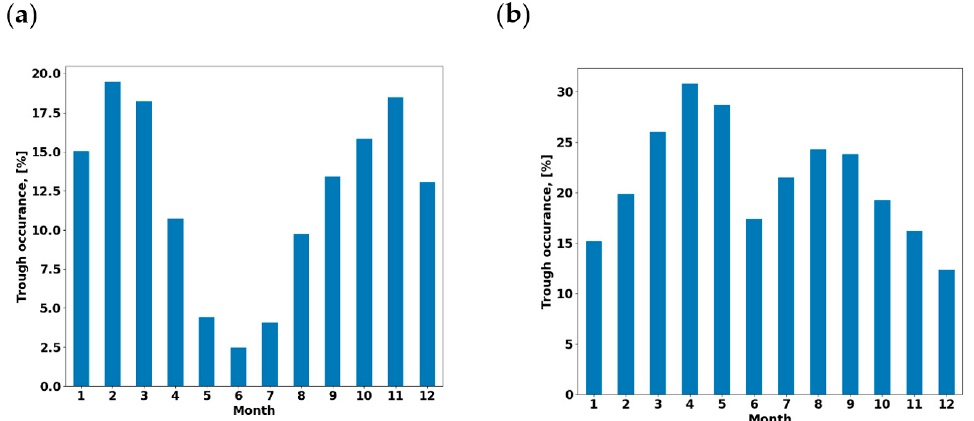
Figure 9. Seasonal variation in the MIT occurrence rate for the northern and southern hemispheres. ( a ) MIT monthly variation in the northern hemisphere; ( b ) MIT monthly variation in the southern hemisphere.